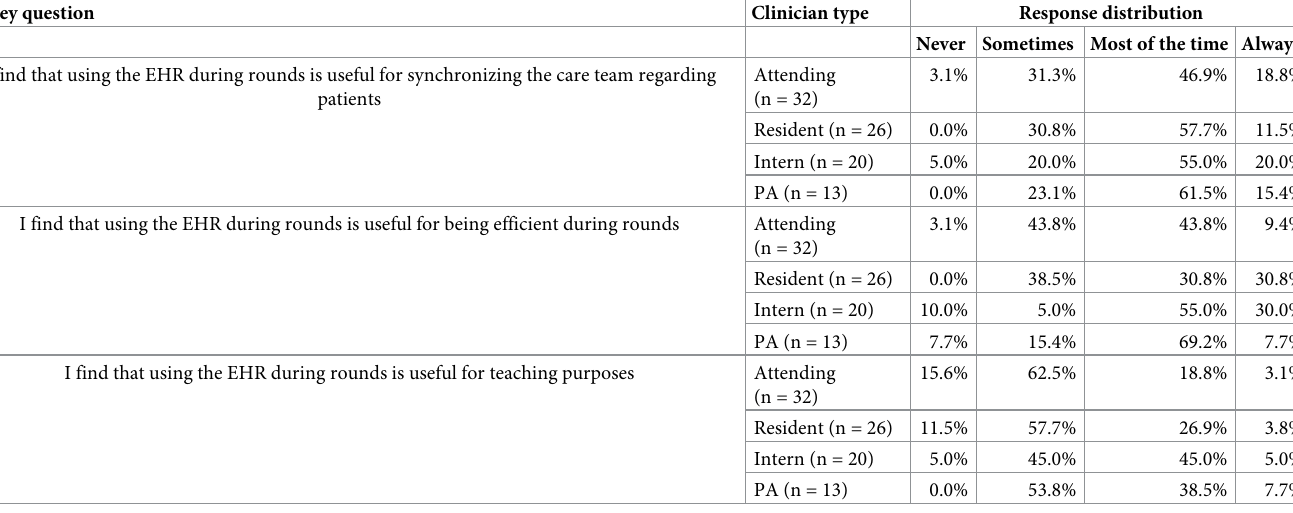
Table 4. Challenges in EHR design and usability: Survey responses based on clinician type. Survey